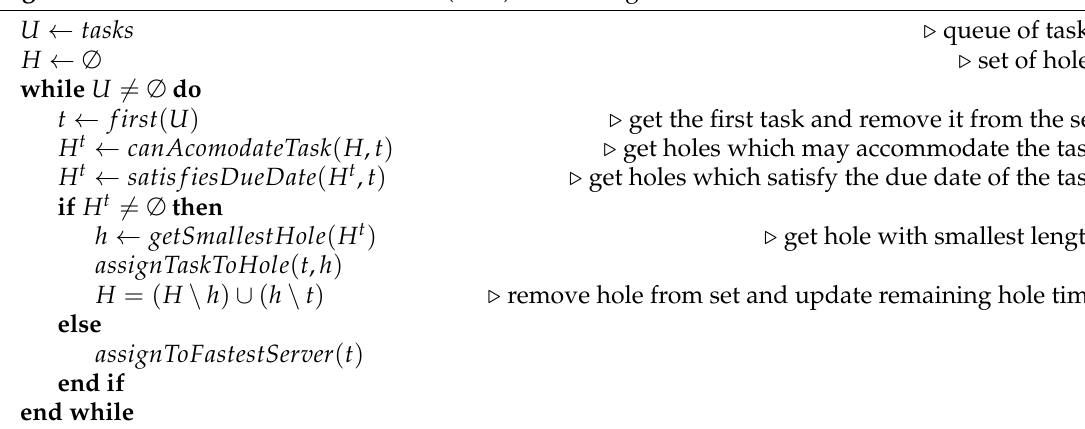
Algorithm 2 Schema of the Best Fit Hole (BFH) scheduling